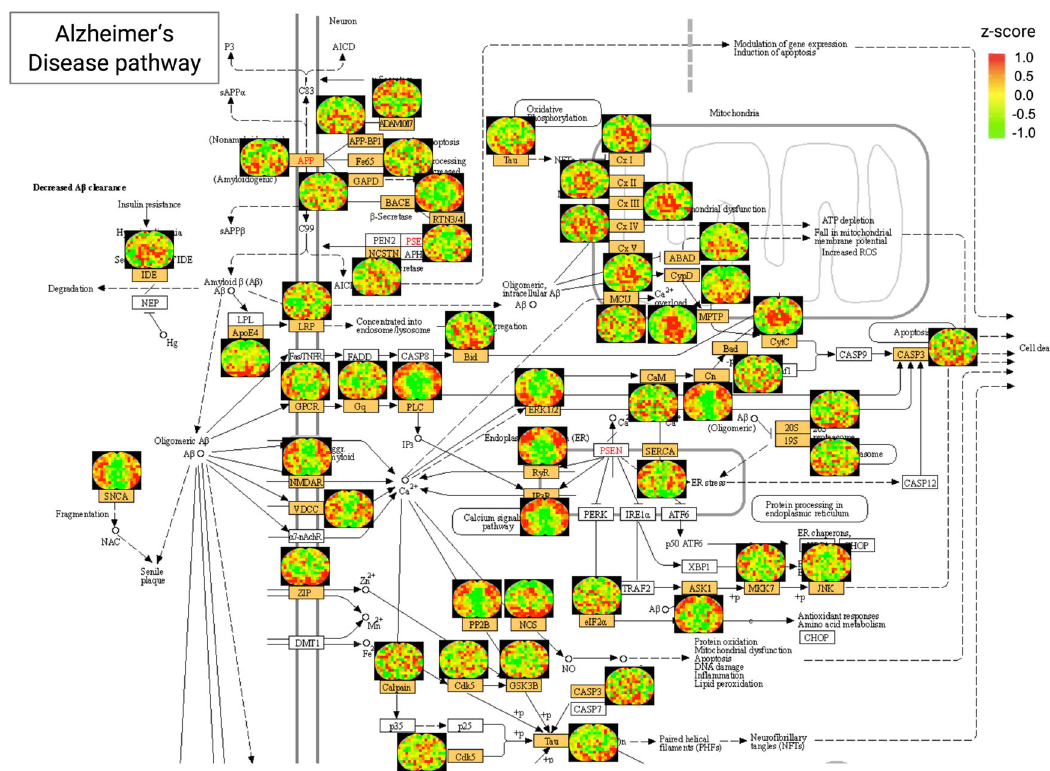
Fig. 6 | Cerebral distribution maps of key proteins involved in the KEGG pathway of Alzheimer ’ s disease acquired by MASP. The z-score color scale is from − 1.0 (green) to 1.0 (red). The orange boxes on the KEGG pathway plots denote the proteins quanti fi ed by MASP.